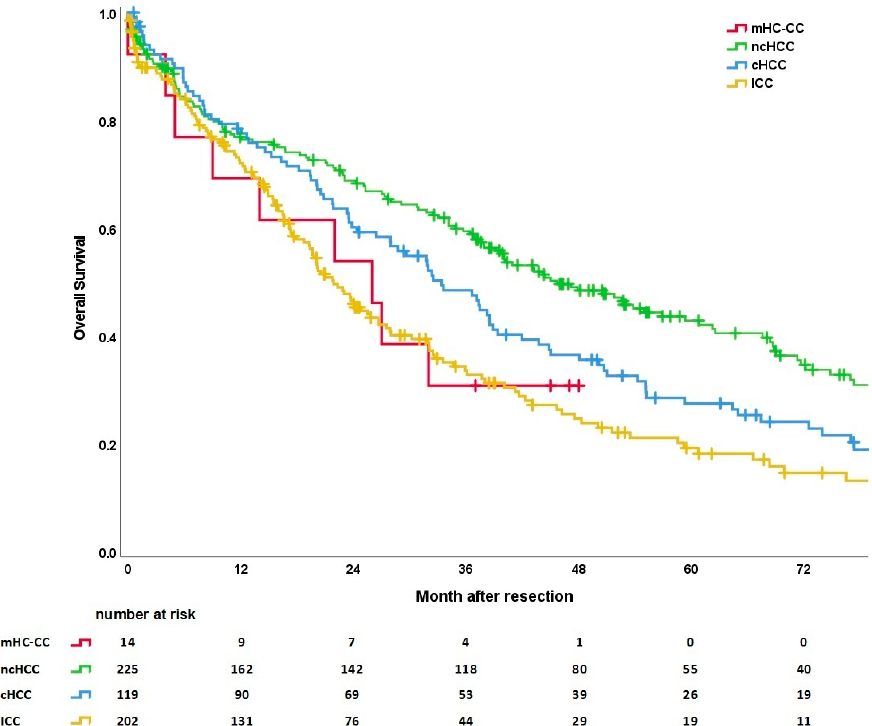
Figure 3. Overall survival curves according to tumor entity ( p < 0.001). Subgroups mHC-CC vs. ncHCC ( p = 0.089), mHC-CC vs. cHCC ( p = 0.390), mHC-CC vs. ICC ( p = 0.882), ncHCC vs. cHCC ( p = 0.029), ncHCC vs. ICC ( p < 0.001), and cHCC vs. ICC ( p = 0.033). Six patients with OLT for mHC-CC were excluded.